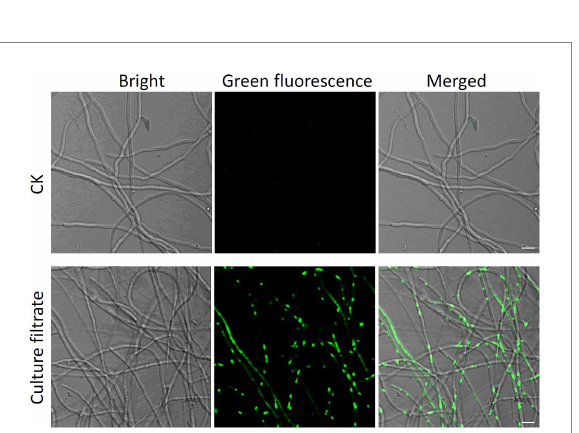
FIGURE 6 Effect of B. halotolerans strain Pl7 culture filtrate against the membrane permeability of B. dothidea hyphae, as demonstrated by SYTOX green staining. Bar = 10 μ